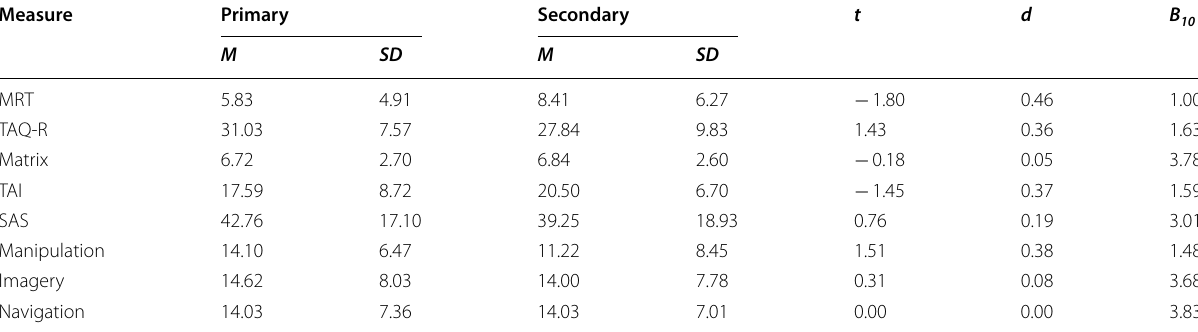
Table 5 Results of t tests examining differences between primary versus secondary teachers